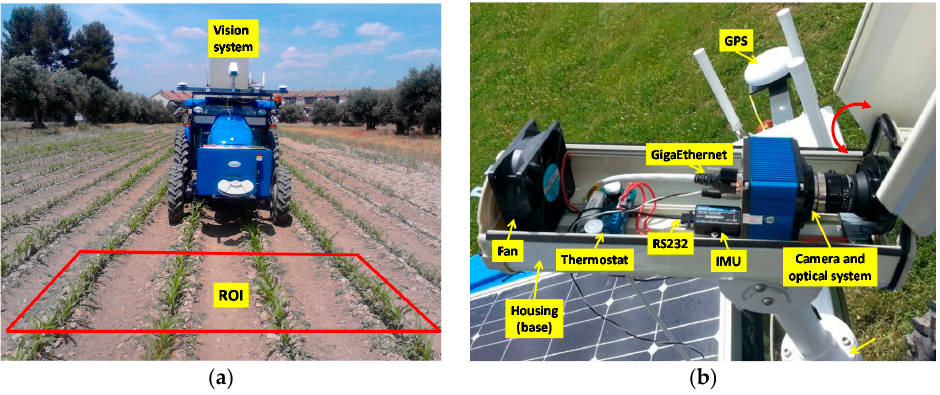
Figure 11. Machine vision system: ( a ) onboard the autonomous vehicle; ( b ) camera and optical systems and other elements in a housing system. Images adapted and taken from [47]